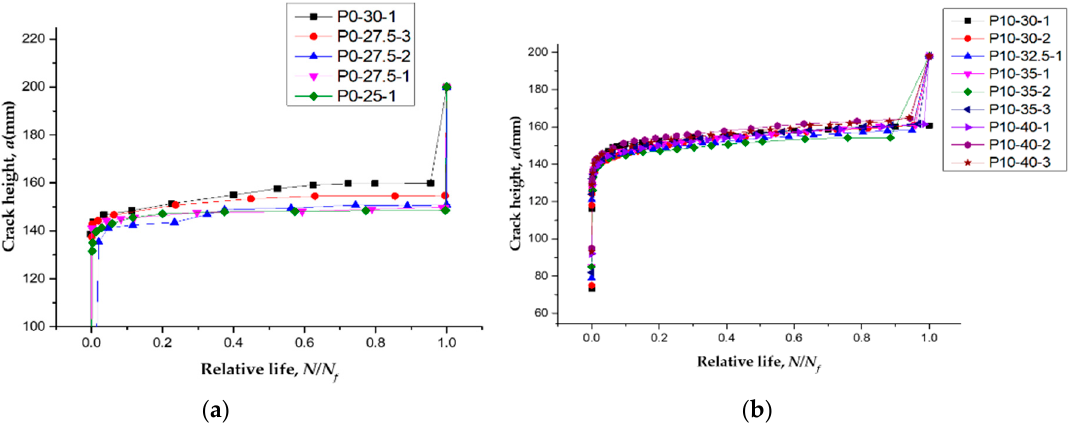
Figure 11. Experimental a - N curves for specimens with different prestressing levels. ( a ) RC beams strengthened with non-prestressed CFL; ( b ) RC beams strengthened by CFL with a prestressing level of 10%. Polymers 2019 , 11 , x FOR PEER REVIEW